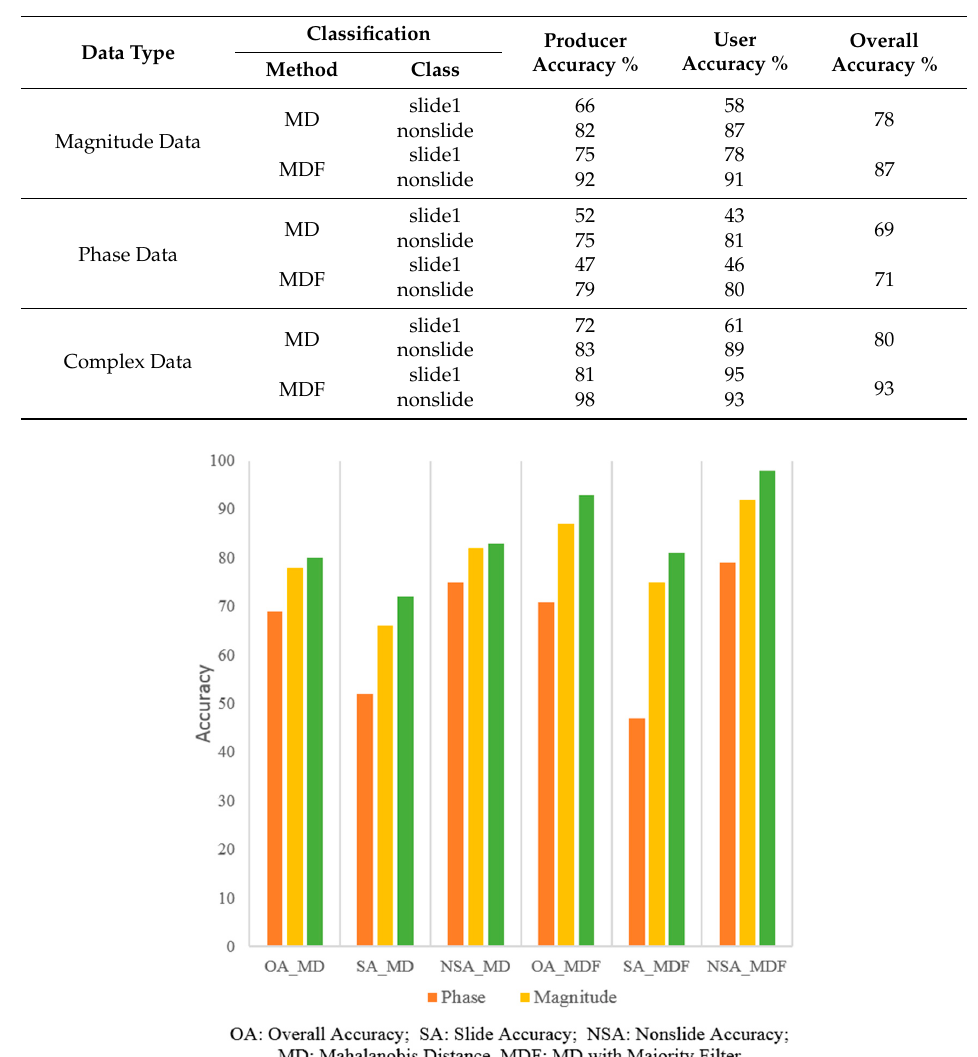
Figure 6. Accuracy comparison of the Mahalanobis distance classification and with majority filter, of the segment Sample 1, for the phase, magnitude, and complex data.